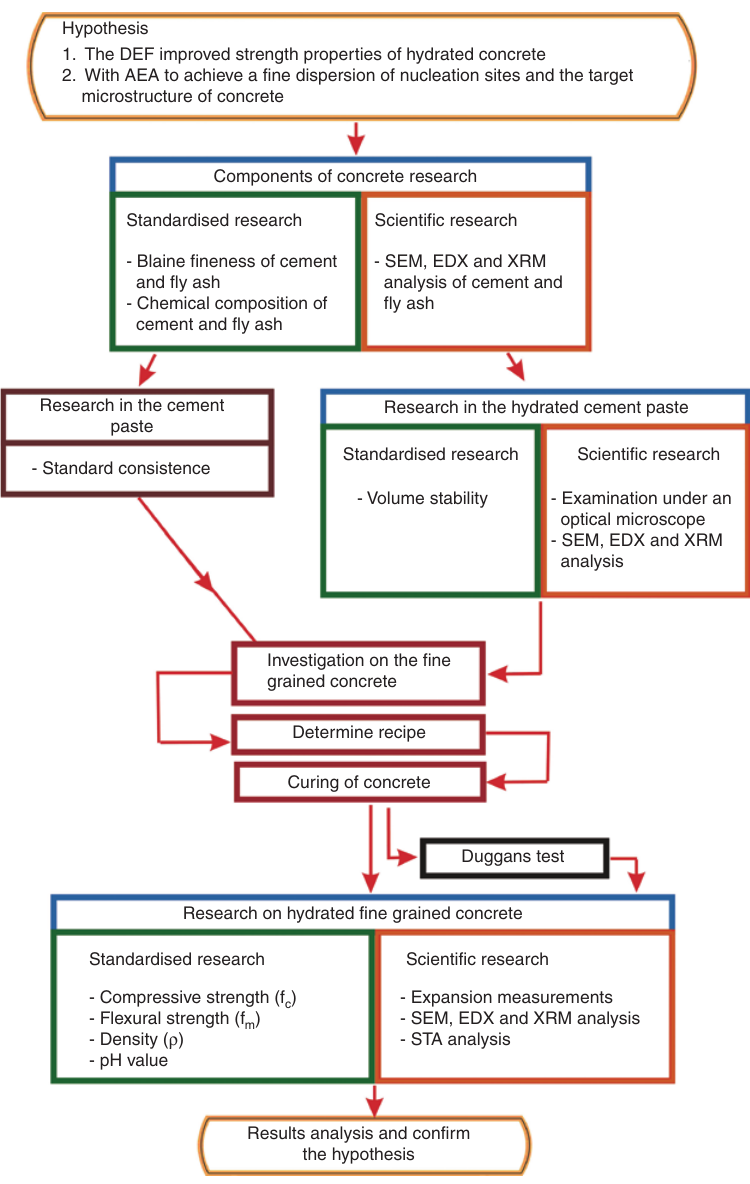
Figure 1 Experimental design